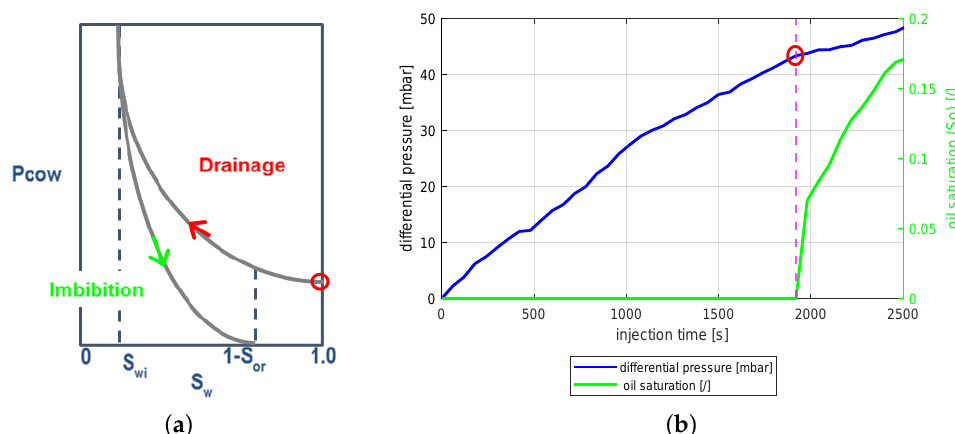
Figure 13. Typical drainage and imbibition curves ( a ); the development of differential pressure and oil saturation during initial oil flooding in the micromodel ( b